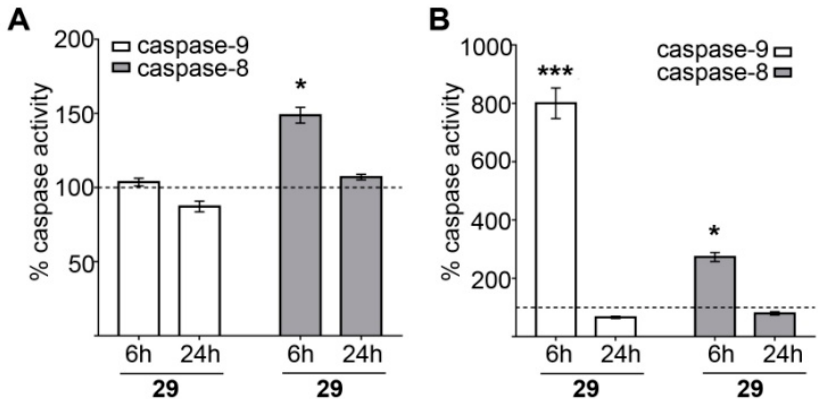
Figure 6. Caspases activity in HEK293 ( A ) and MCF-7 ( B ) cells upon compound 29 treatment. Cells were treated with 29 for 6 and 24 h. The activity is given as a percentage of the control group (untreated cells) considered 100%. Data are expressed as mean ± S.E.M from two experiments, performed in triplicate (*— p < 0.05, ***— p < 0.001 compared with corresponding control cells (shown as a dotted line); Wilcoxon t -test).